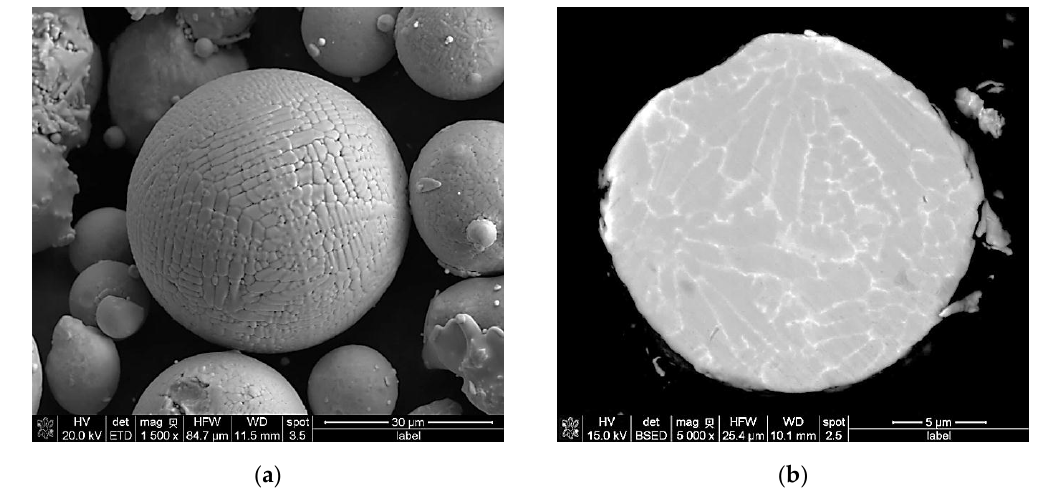
Figure 4. ( a ) Backscattered electron (BSE) image showing the powder surface morphology; ( b ) BSE image of a mounted, sectioned and polished IN718 powder particle showing the internal microdendritic structure.